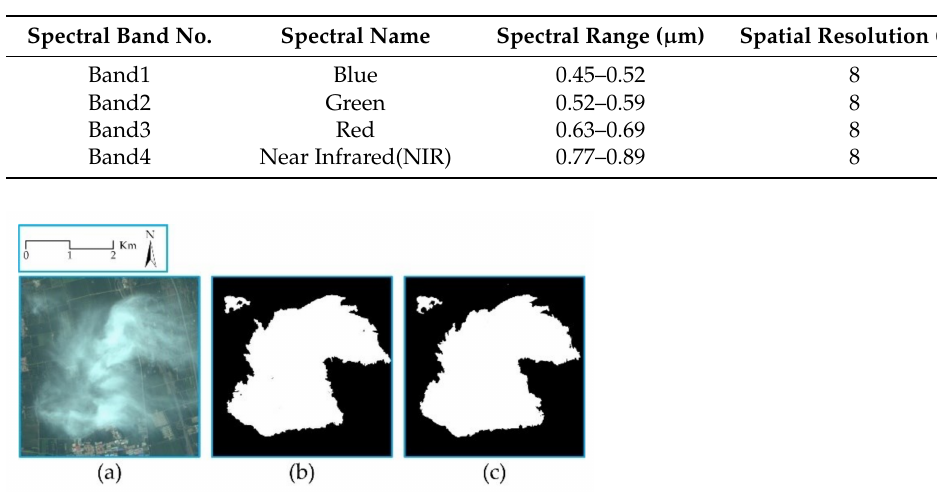
Figure 4. Ground truth labeled by different operators. ( a ) The original RGB image; ( b ) the ground truth labeled by operator I; ( c ) the ground truth labeled by operator II. The coordinates of ( a ) are 117.0E and